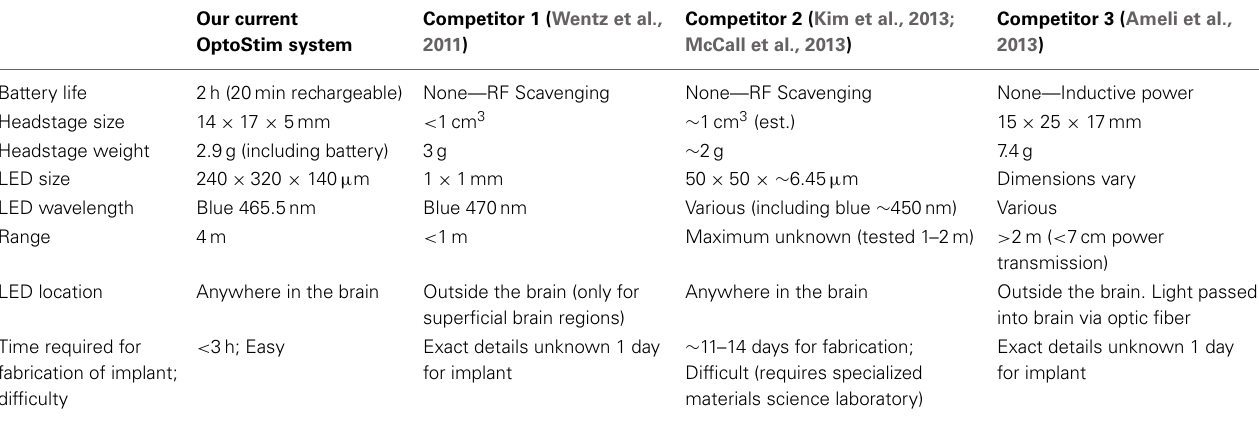
Table 1 | Comparison of our wireless stimulation system with other available wireless optogenetic